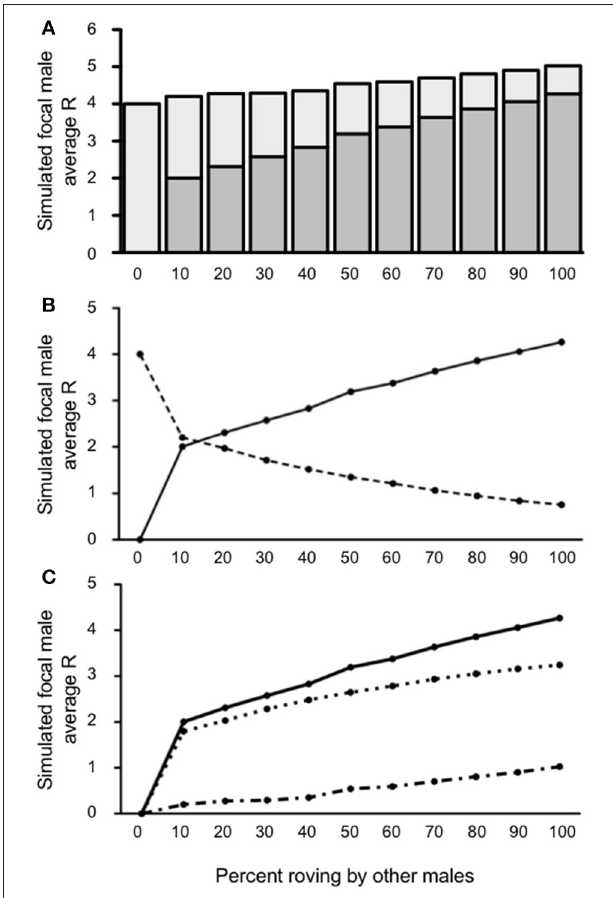
FIGURE 7 | Reproductive success for simulated roving focal male in Condition 3 at pair population 1,000 with 40% wandering and unpaired females. (A) Mean reproductive success (R) obtained by the simulated roving focal male at each percentage of roving in the population, split between R gained via extra-pair copulations (EPC; dark gray) and intra-pair copulations (IPC; light gray). (B) Average R gained via EPCs (solid line) and IPCs (dashed line) by the simulated roving focal male as the percentage of roving in the population increases. (C) Average R gained via EPCs ( E , solid line), average R lost via cuckolding ( C , dotted line), and total change in R ( 1 R, dash-dotted line) for the simulated roving focal male as the percentage of roving in the population